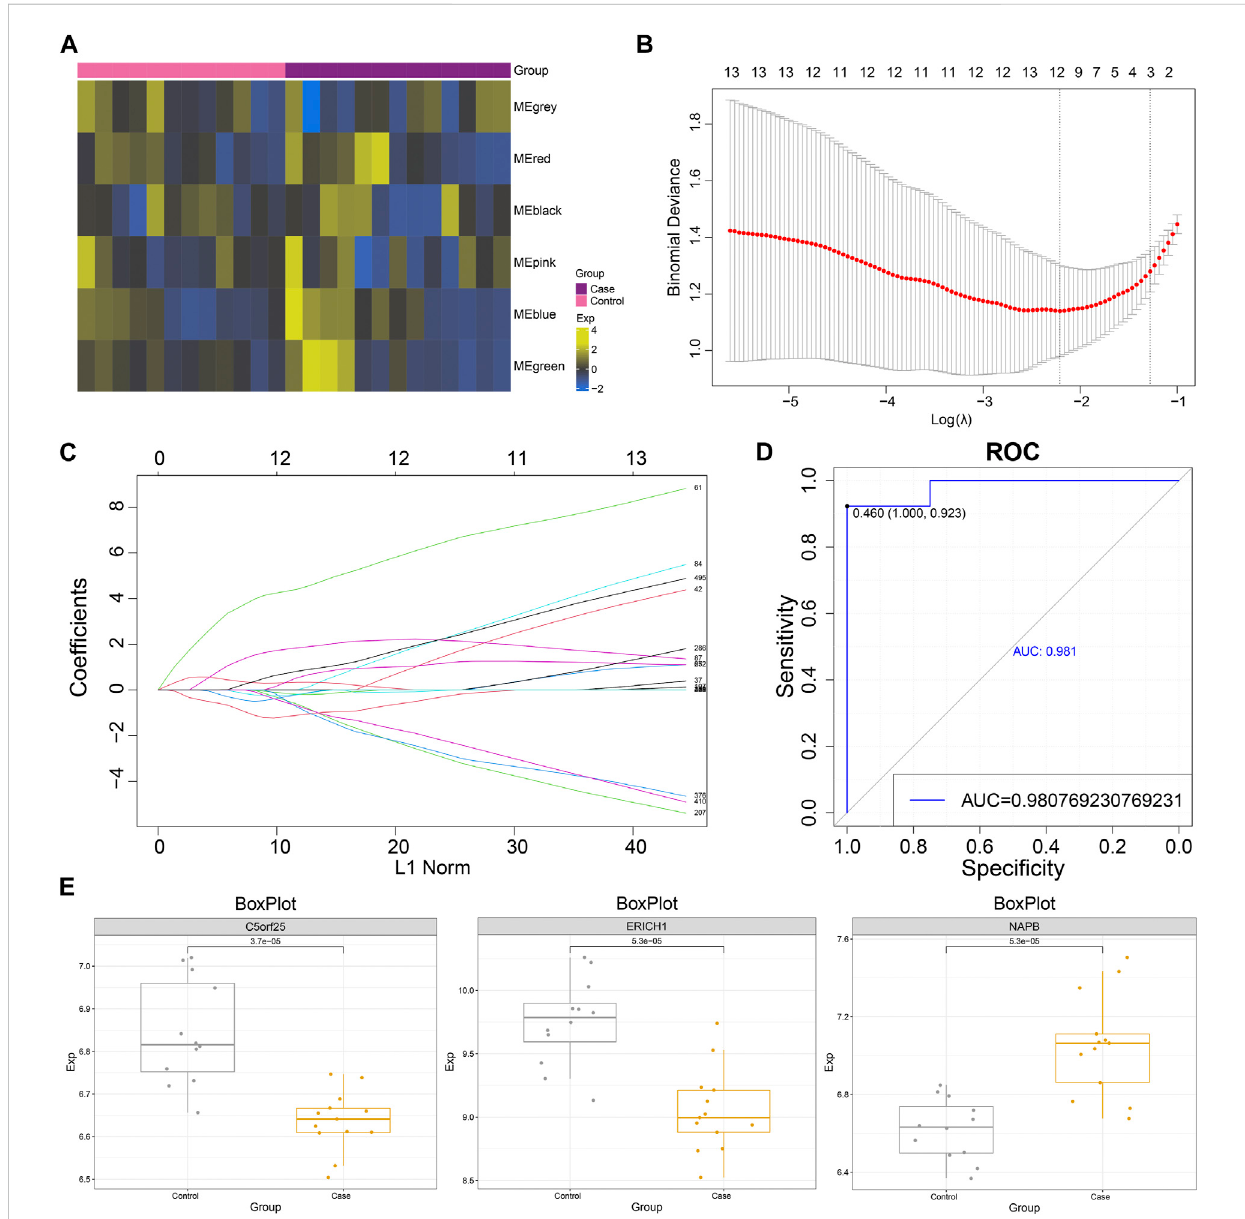
FIGURE 4 The myasthenia gravis dysregulated gene co-expression module-based clinical model has signi fi cant diagnostic ef fi cacy. (A) Heat map demonstrating signi fi cant enrichment of MG dysregulated gene co-expression module gene (GSVA) scores in Case-Control. (B) Lambda plot demonstrating model performance of the set of MG dysregulated gene co-expression module functional genes with diagnostic ef fi cacy at different Lambda (single factor signi fi cant genes were selected for Lasso modeling). (C) Lasso model Plot showing the model con fi dence of the set of functional genes with diagnostic ef fi cacy of MG dysregulated gene co-expression module at different log (Lambda). (D) ROC curve showing the ROC curve of MG dysregulated gene co-expression module-based model. (E) Box plot showing the expression level of model